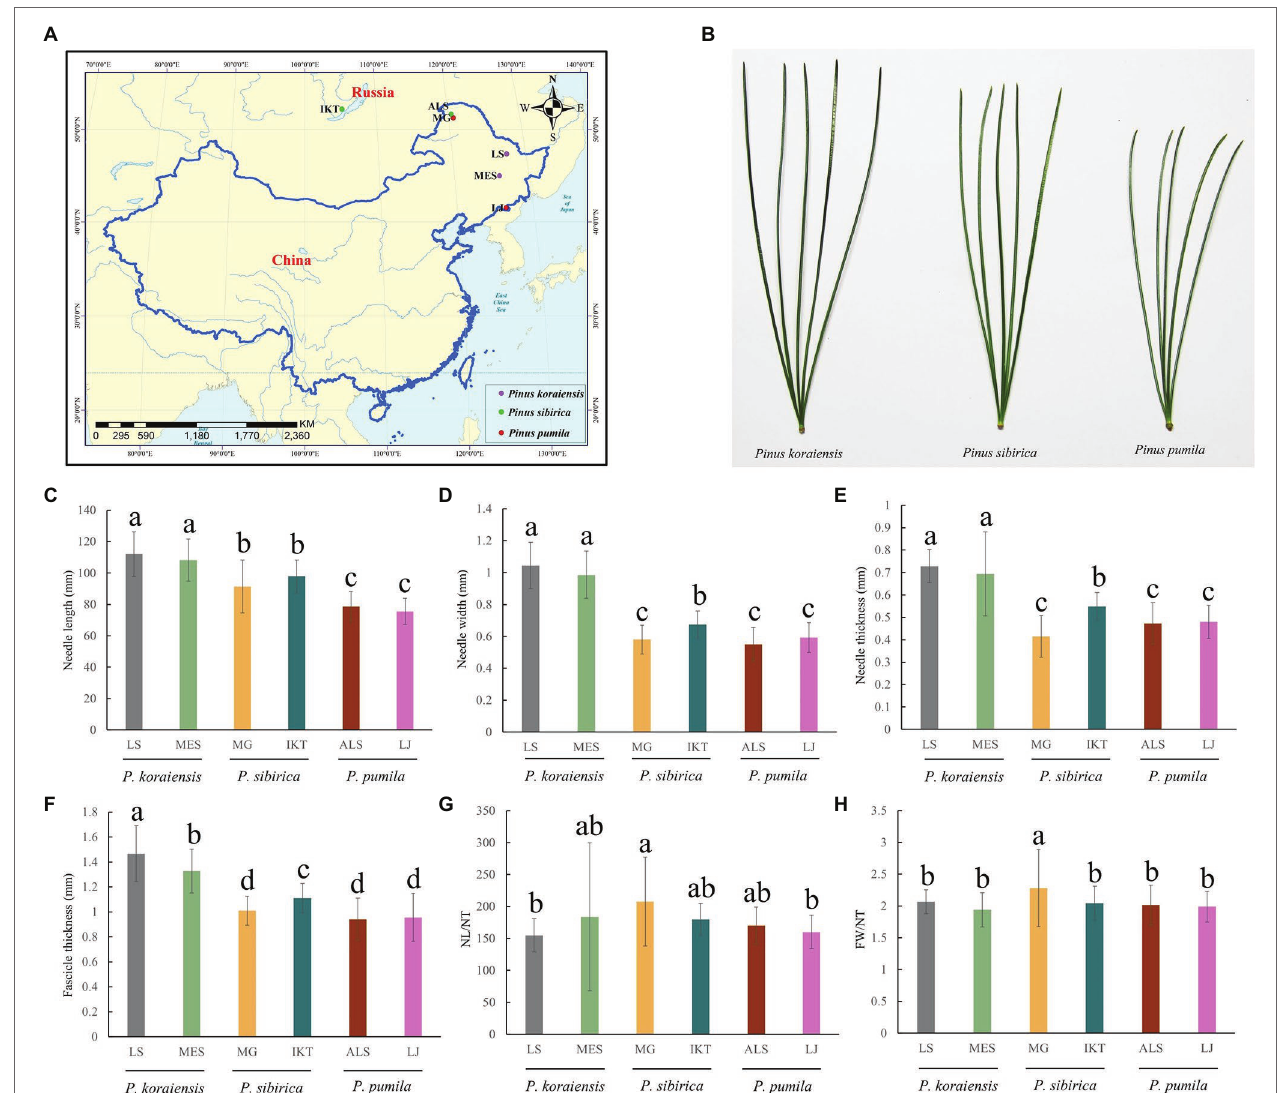
FIGURE 1 | Variation of needle traits in natural populations of three five-needle pines. (A) Location of three five-needle pines samples collected in this study. (B) Phenotypes of the three five-needle pines in natural conditions. (C) Needle length (NL). (D) Needle width (NW). (E) Needle thickness (NT). (F) Fascicle width (FW). (G) NL/NT. (H) FW/NT. All data were given as means ± SE. The different lowercase letters above the histogram bars represents significant differences across the two panels ( p < 0.05). One-way ANOVA was used to generate the p values. The x-axis represents the populations of Pinus pumila (ALS and LJ), Pinus sibirica (MG and IKT), and Pinus koraiensis (LS and MES). The y-axis indicates the phenotypes. NL, needle length; NW, needle width; NT, needle thickness; and FW, fascicle